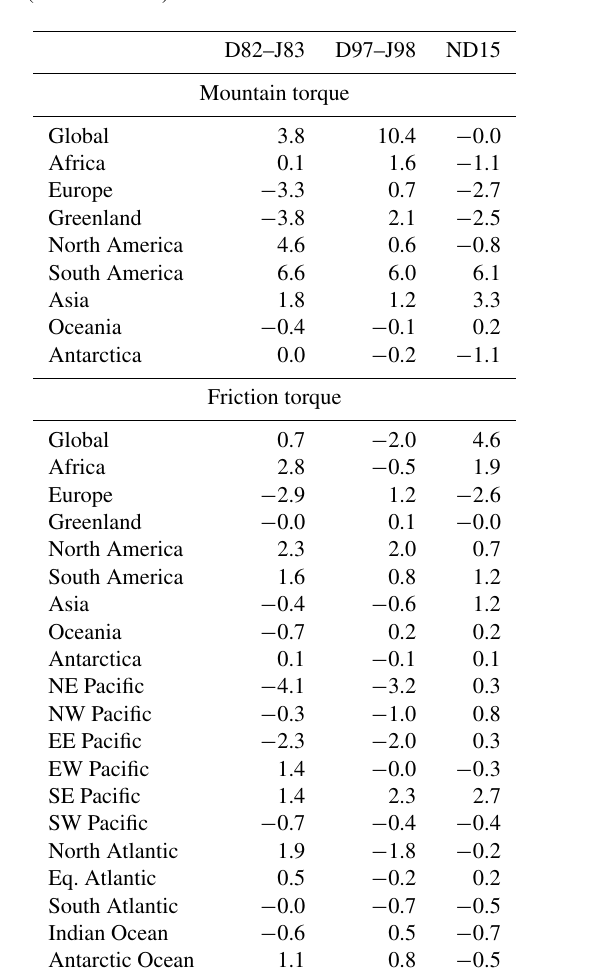
Table 1. Contributions to the mountain and friction torques exerted by the solid Earth onto the atmosphere in Hadley (i.e., 10 18 Nm), averaged over December–January for the 1982–1983 and 1997– 1998 EP events (columns D82–J83 and D97–J98, respectively) and averaged over November–December for the 2015–2016 EP–CP event (column ND15).